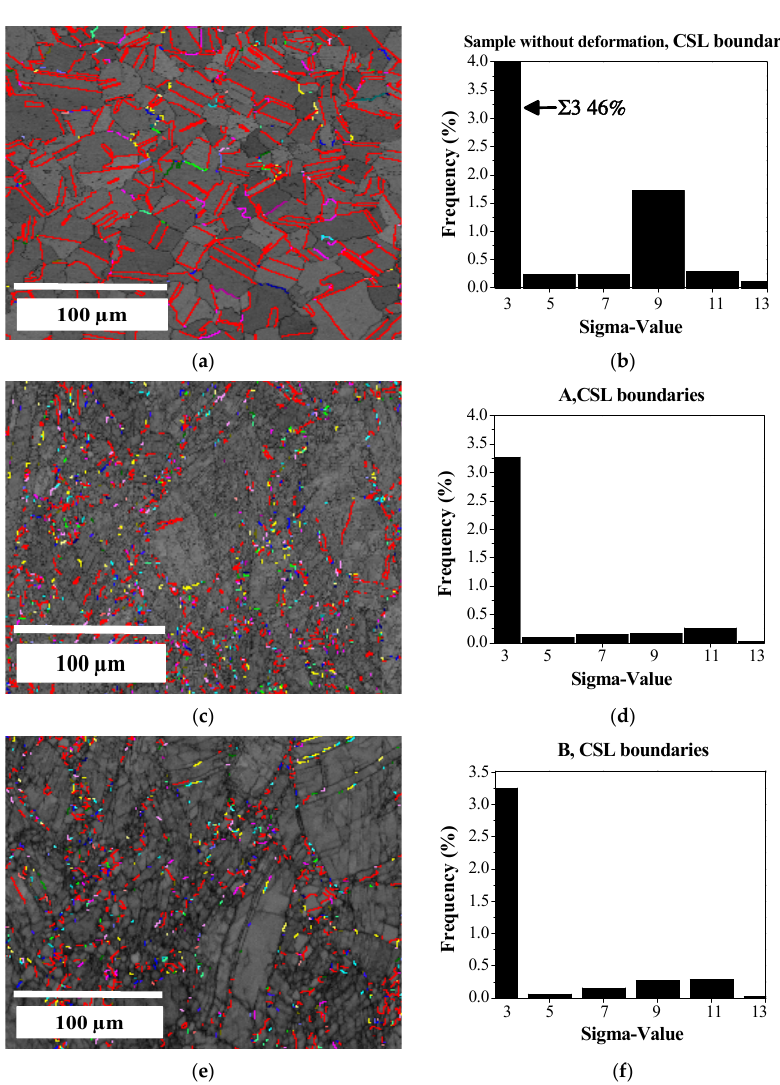
Figure 7. EBSD results of CSL boundaries for specimens ( Σ 3 in red): ( a ) sample without deformation; ( c ) Specimen A; ( e ) Specimen B; ( b,d,f ): Frequency histogram of sigma-value